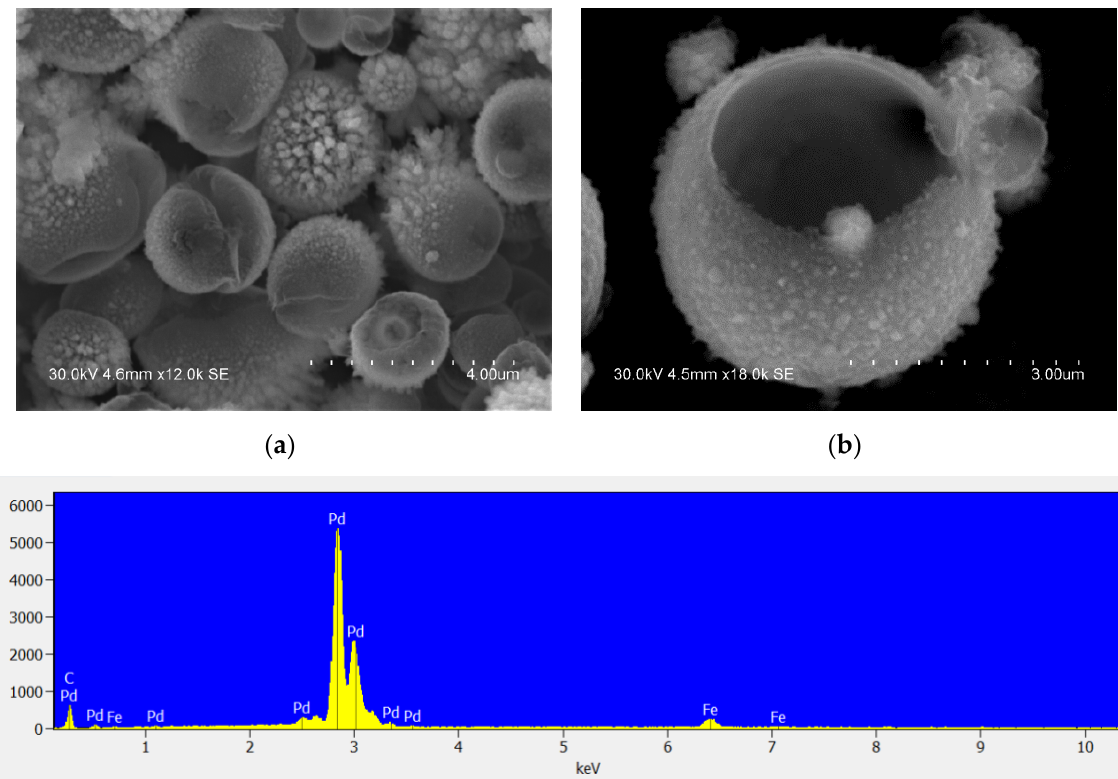
Figure 8. ( a , b ) Morphology of the product of acid treatment of Fe@Pd core–shell particles (hollow particles), different magnifications, ( c ) EDS of the product of acid treatment of Fe@Pd core–shell particles (hollow particles of the Pd-based alloy).